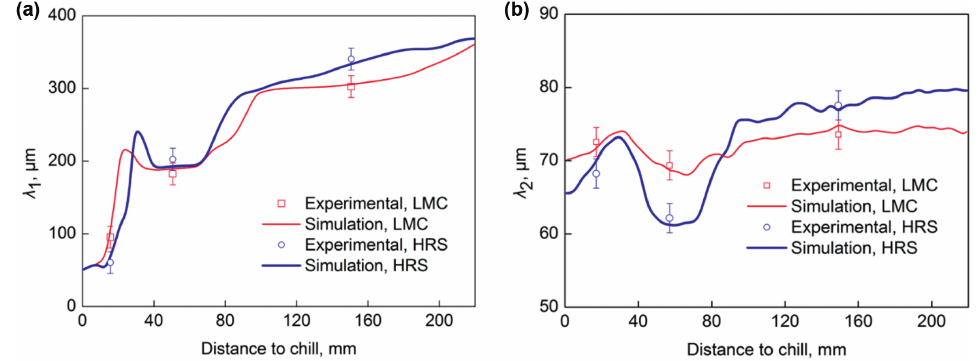
Figure 12: Comparison between simulation and experimental results: (a) PDAS and (b)